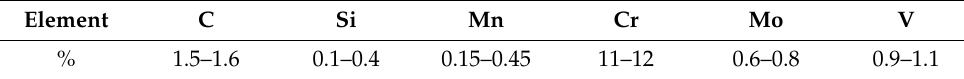
Table 2. Composition of the X155CrVMo12 tool steel substrate.